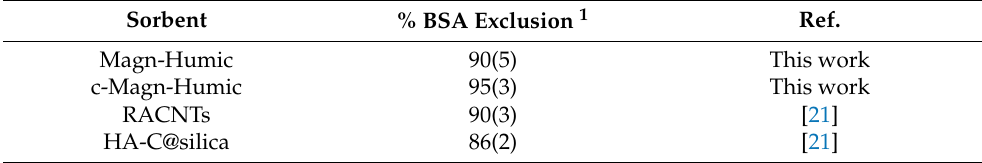
Table 2. Protein exclusion (%) observed in bovine serum albumin (BSA) solution (RSD < 6 %, n = 3).